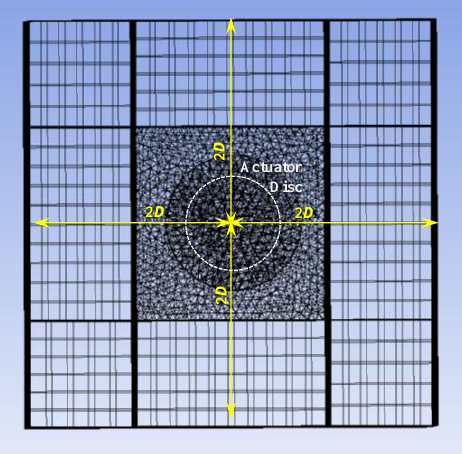
Figure 8. Cells around the rotor.